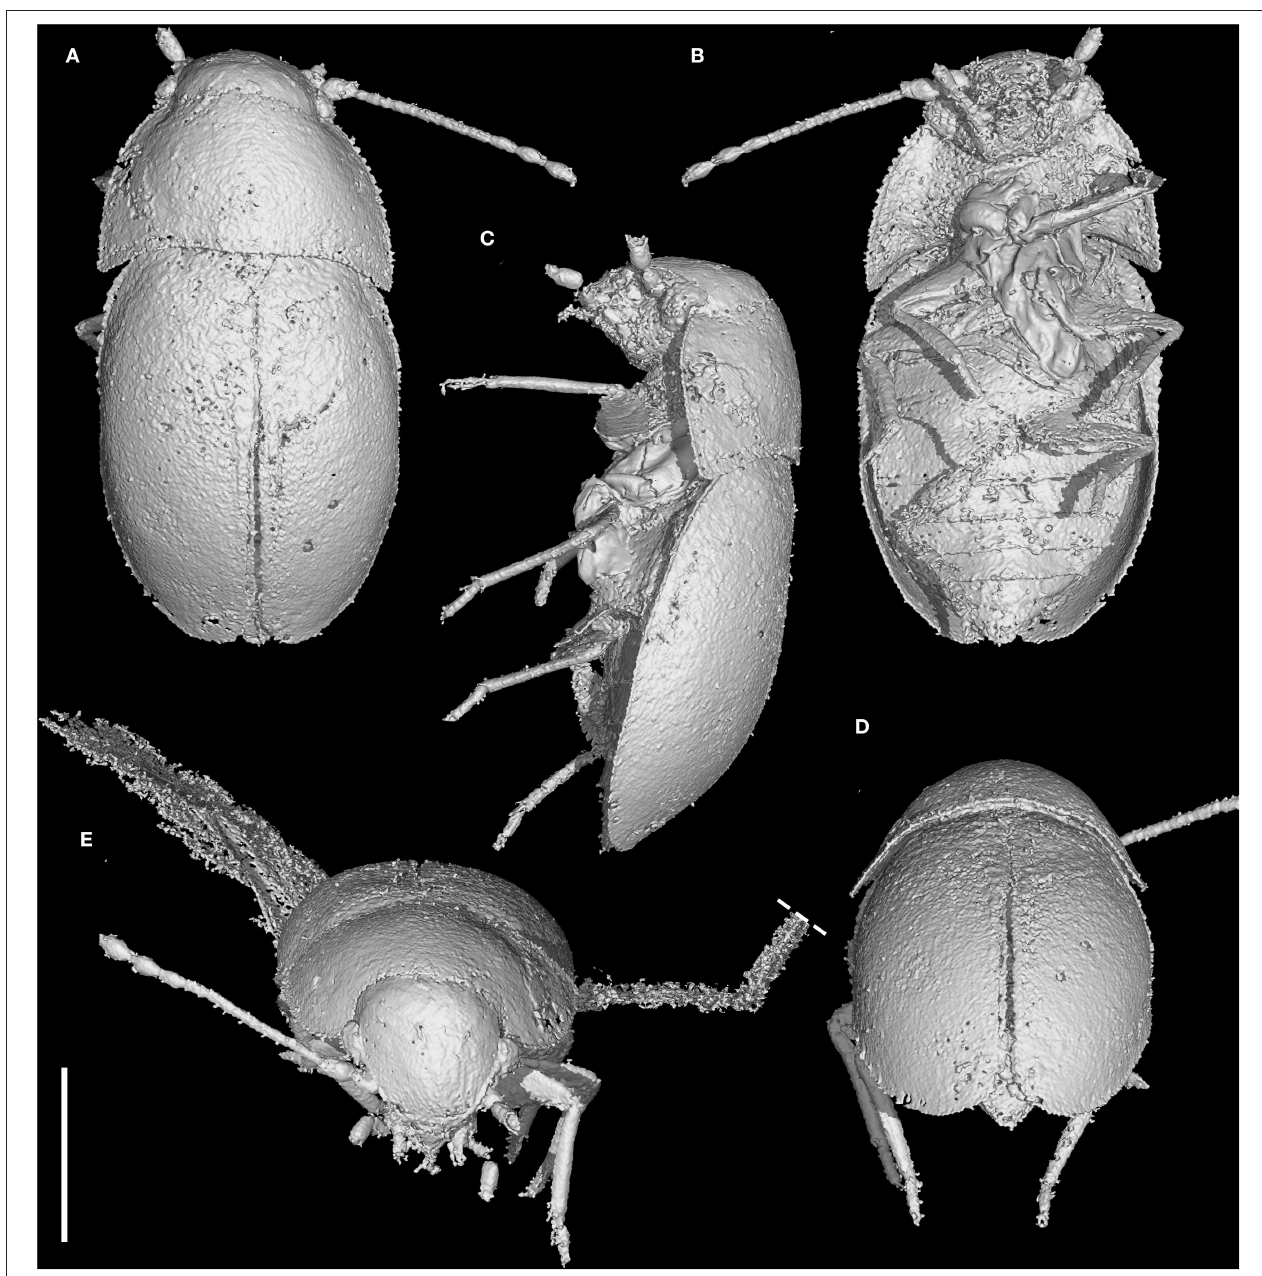
FIGURE 4 | X-ray microtomographic reconstruction of Crenossidium slipinskii Li, Newton and Cai gen. et sp. nov. , holotype, NIGP180053, with hind wings removed in (A–D) . (A) Dorsal view. (B) Ventral view. (C) Lateral view. (D) Posterodorsal view. (E) Anterodorsal view. Scale bar: 200 µ m.